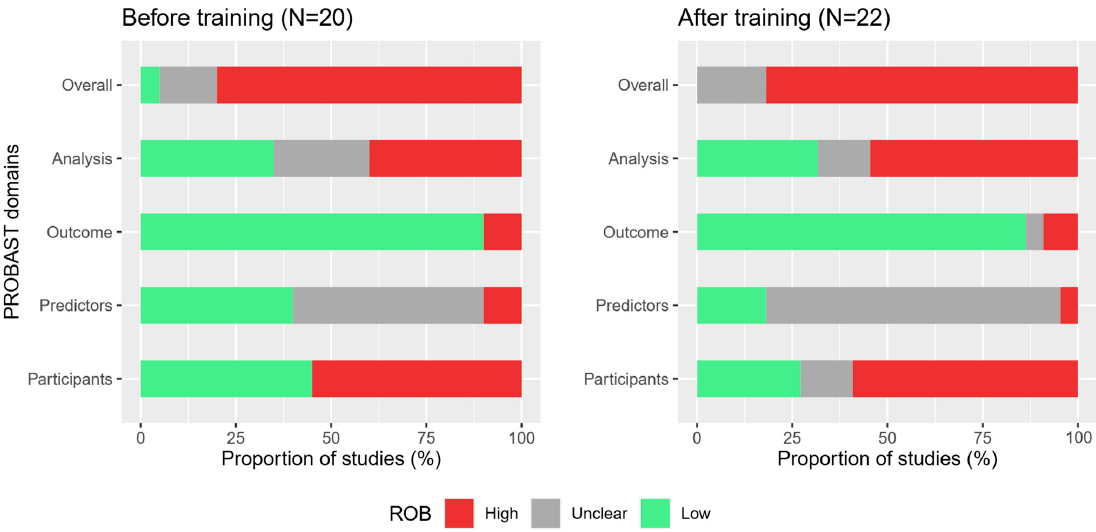
Figure 2. Overall and domain-specific ROB ratings of studies assessed before (n = 20) and after training (n = 22).